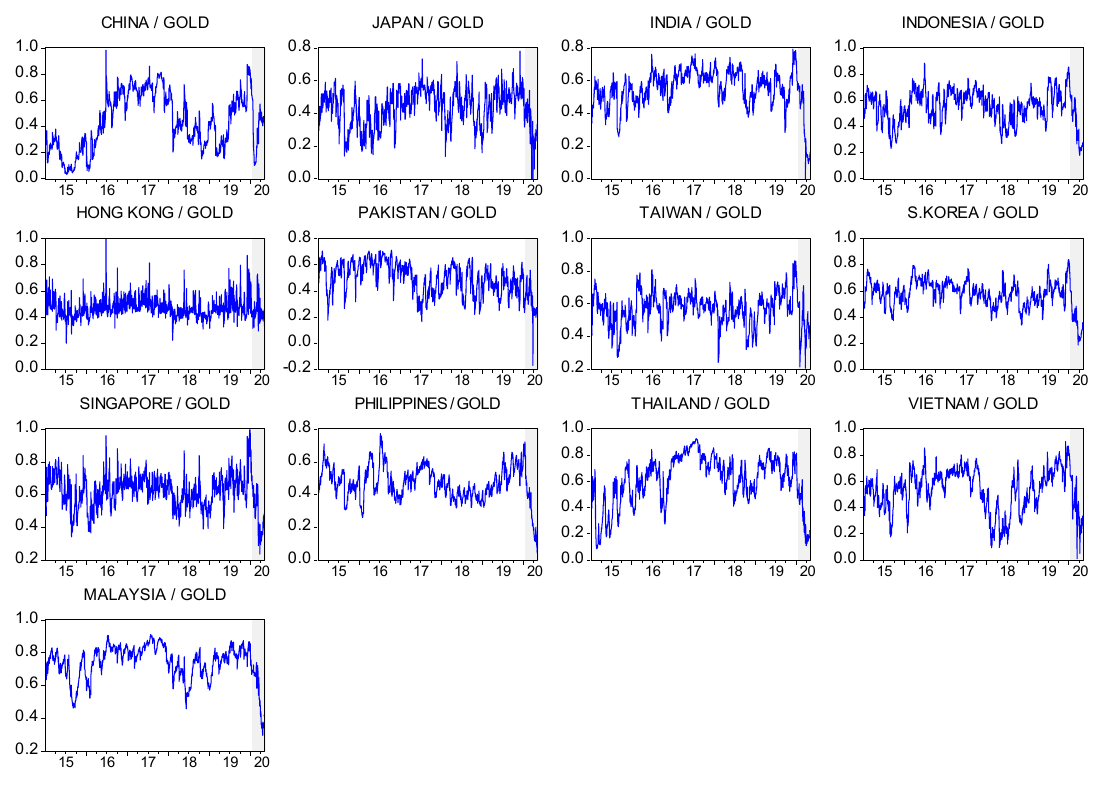
Figure 2. Optimal weights. Table 4. Optimal weights and hedge ratios.